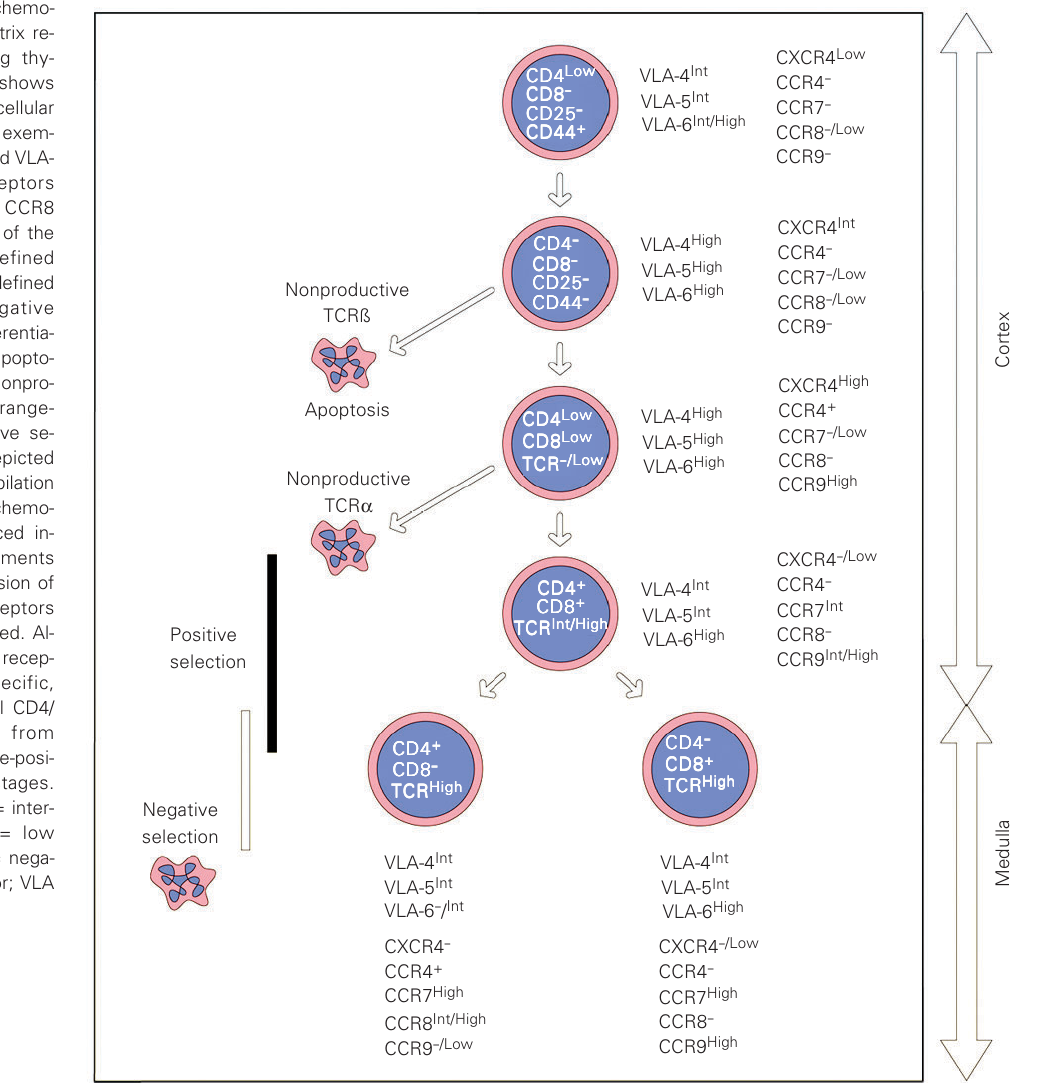
Figure 1. Expression of chemo- kine and extracellular matrix re- ceptors in differentiating thy- mocytes. This scheme shows the expression of extracellular matrix receptors (herein exem- plified by VLA-4, VLA-5 and VLA- 6) and chemokine receptors (CXCR4, CCR4, CCR7, CCR8 and CCR9) as a function of the four TCR α ß/CD4/CD8-defined stages (and CD25/CD44-defined subsets of double-negative cells) of thymocyte differentia- tion. Also, we illustrate apopto- sis points secondary to nonpro- ductive TCR gene rearrange- ments as well as negative se- lection. The patterns depicted are derived from a compilation of data in which VLAs or chemo- kine receptors were traced in- dependently, i.e., experiments looking for the co-expression of these two kinds of receptors have not yet been reported. Al- though some chemokine recep- tors can be subset specific, VLAs can be found in all CD4/ CD8-defined subsets, from double-negative → double-posi- tive → single-positive stages. High = high density; Int = inter- mediate density; Low = low density; + = positive; - = nega- tive; TCR = T-cell receptor; VLA = very late